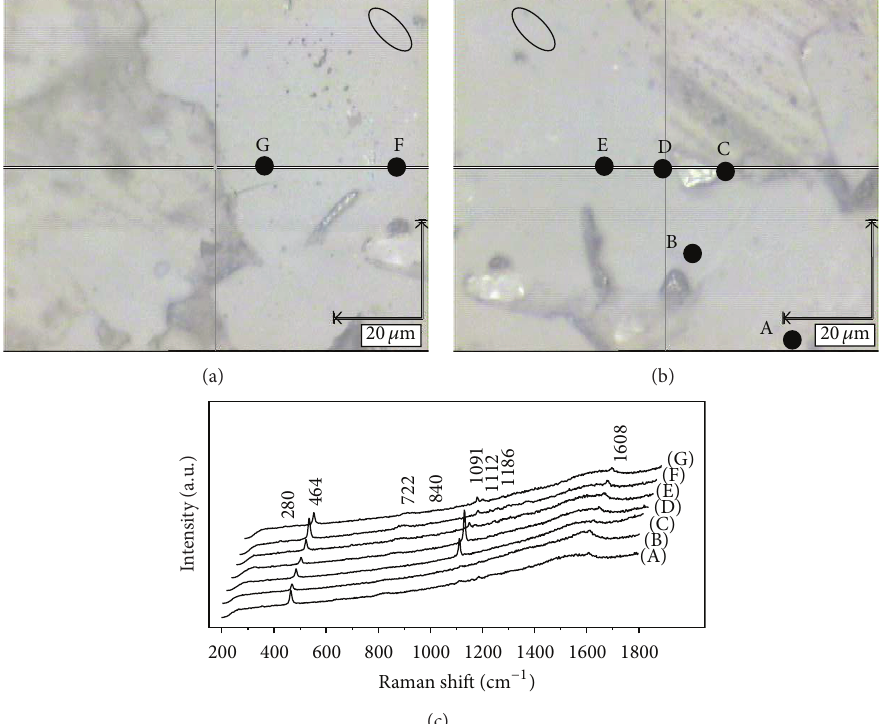
Figure 16: Points of Raman analysis for siliceous rocks of Bafangshan-Erlihe area. Microphotographs in Figures 16(a) and 16(b) under parallel nicols.